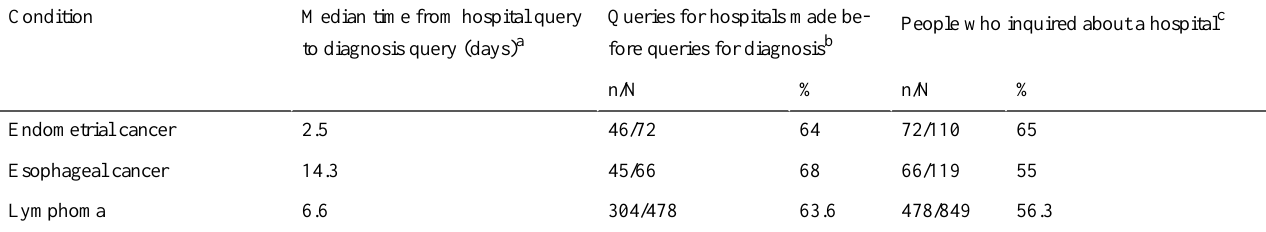
Table 2. The time from the first query for a hospital and the first query indicating the condition, the percentage of times the hospital query occurred before the diagnosis query, and the percentage of people who queried for a hospital. fore queries for diagnosis